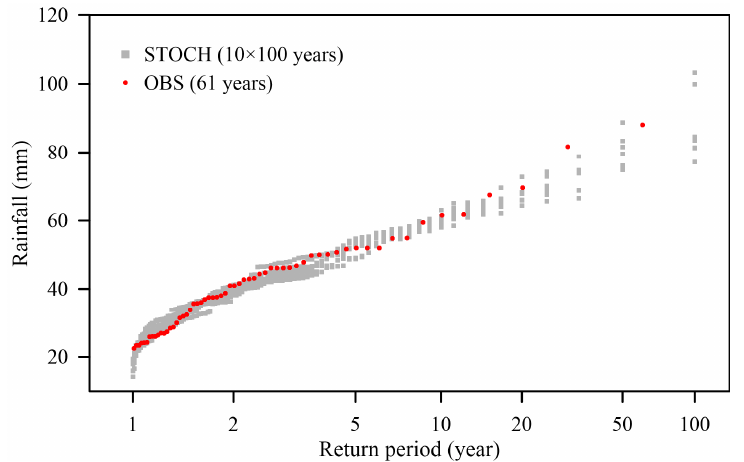
Figure 6. Comparison of empirical probability distributions of observed and model-generated annual maximum rainfall series for Tianshui station.